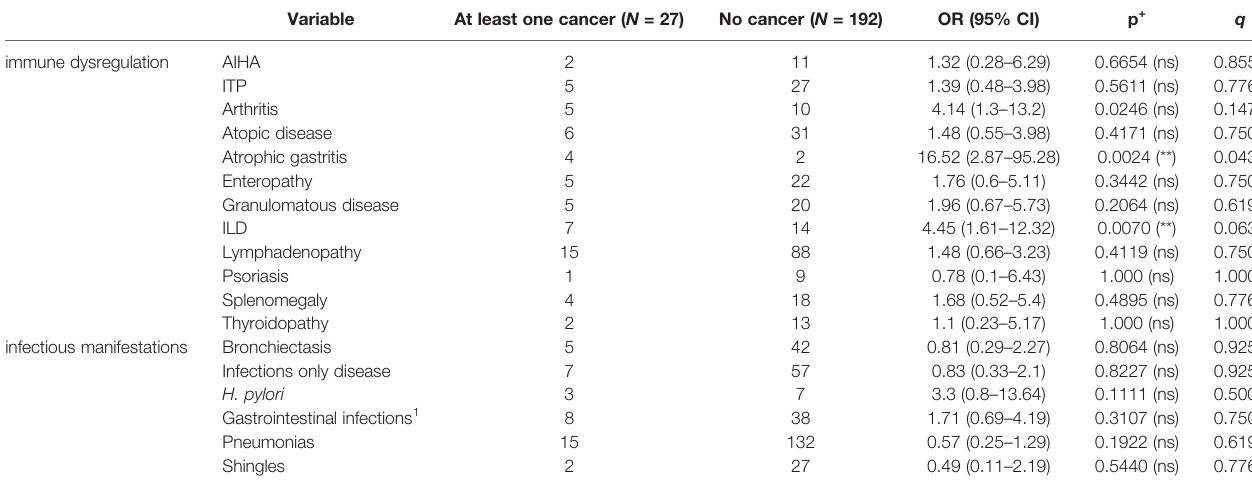
TABLE 3 | Association of infectious and non-infectious manifestations of CVID with cancer. Variable